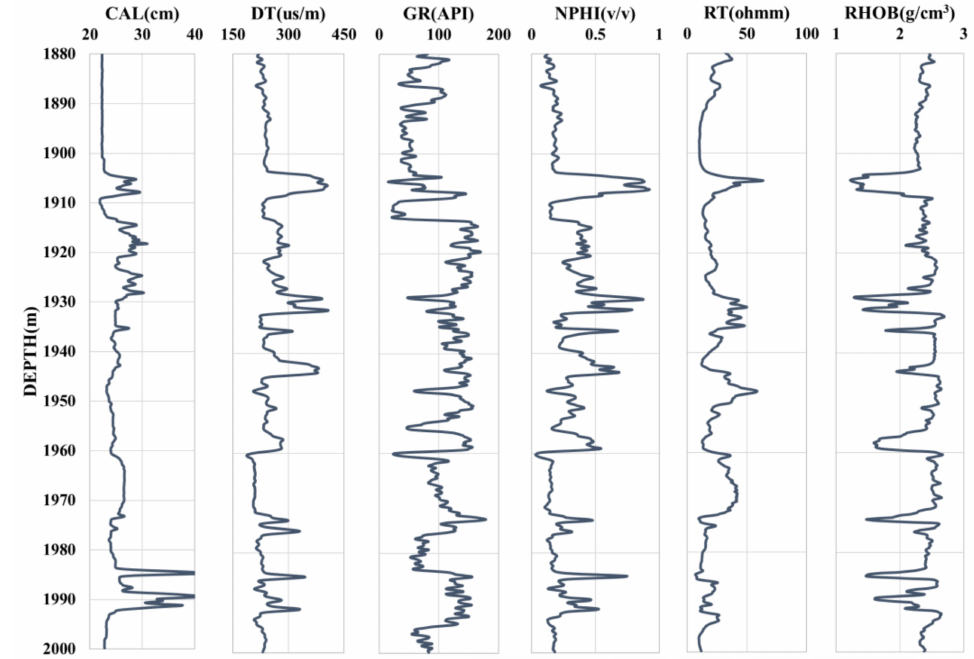
Figure 3. Well logging graph of Well A1 in the studied